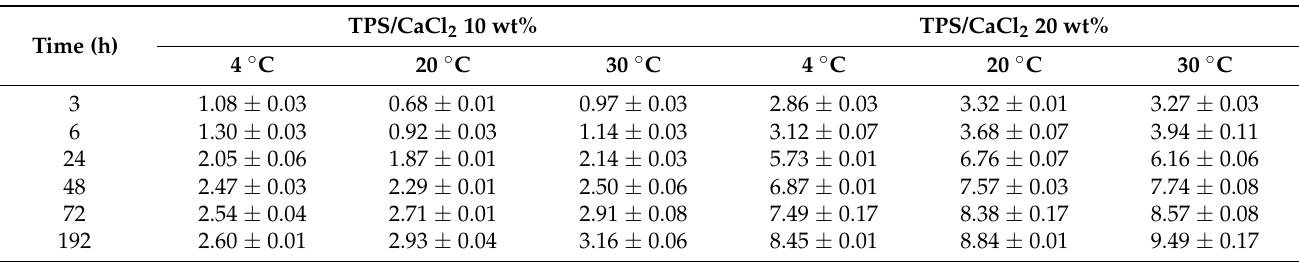
Table 2. Amount of CaCl 2 released (mg) from TPS/CaCl 2 10 wt% and TPS/CaCl 2 20 wt% composite films after different incubation periods at 4, 20 and 30 ◦ C.